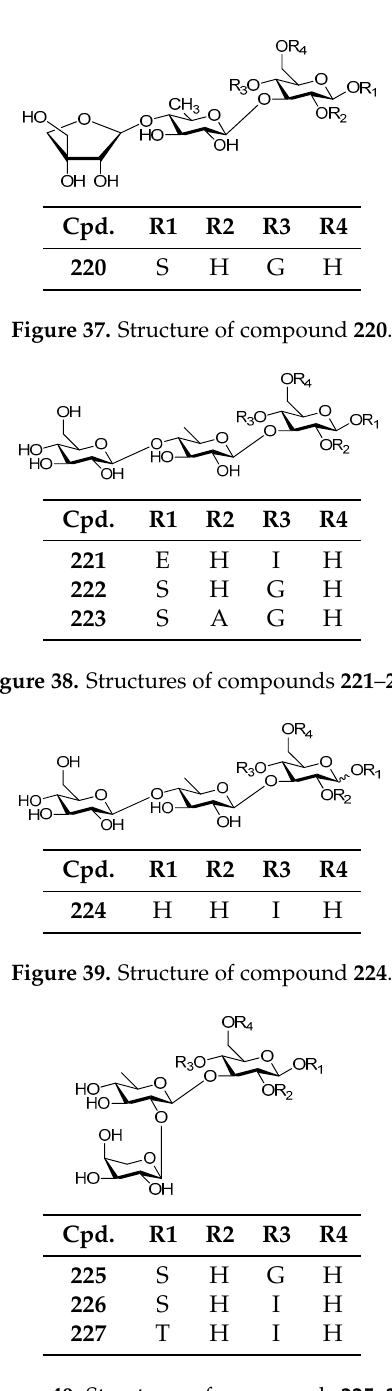
Figure 40. Structures of compounds 225 – 227 .